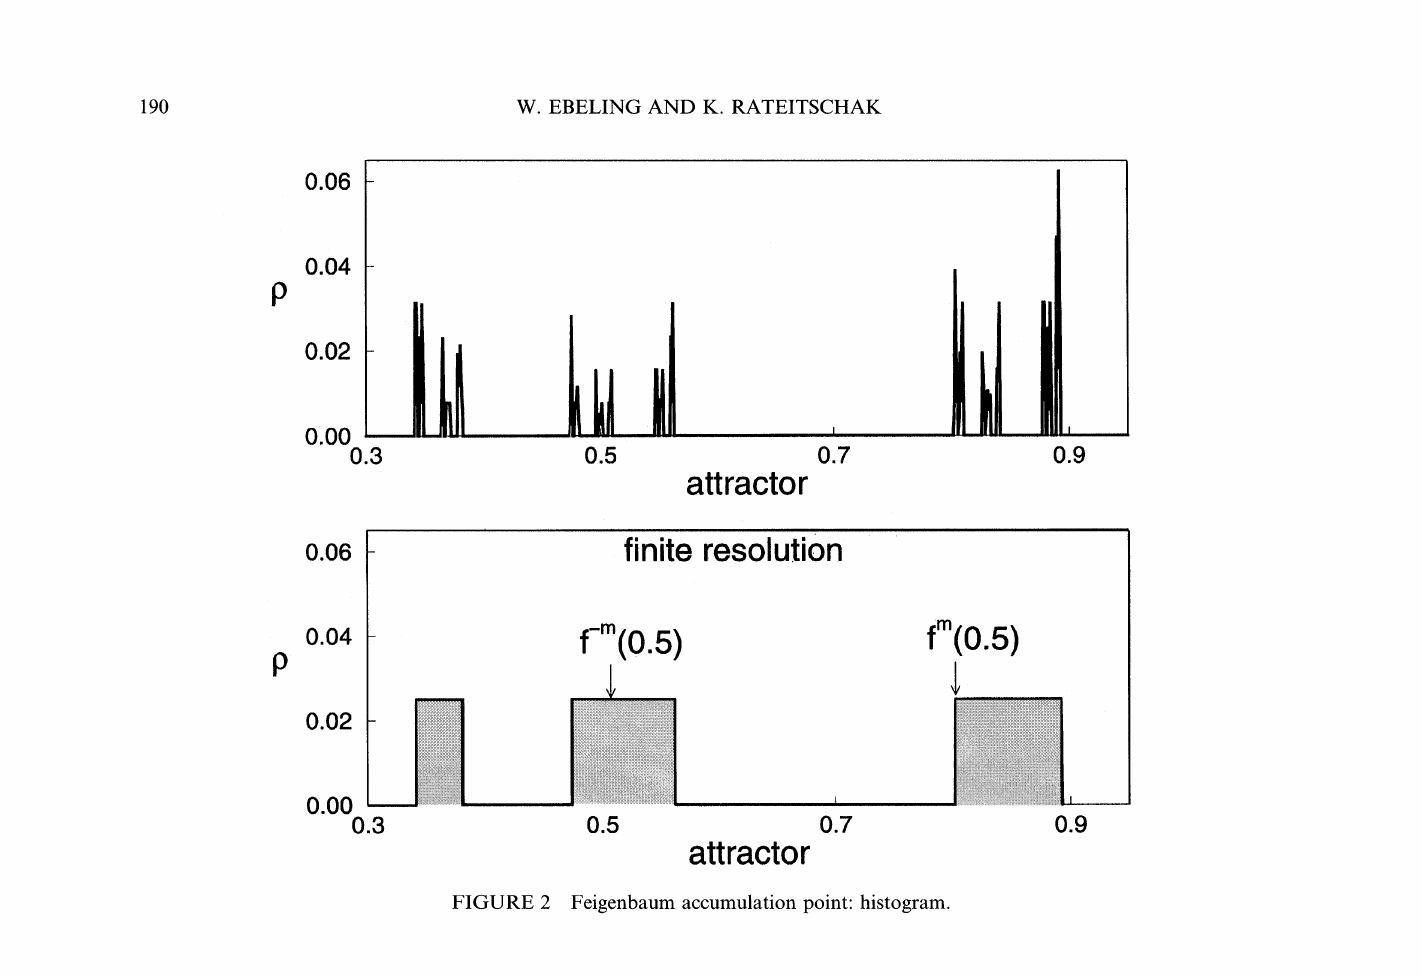
FIGURE 2 Feigenbaum accumulation point: